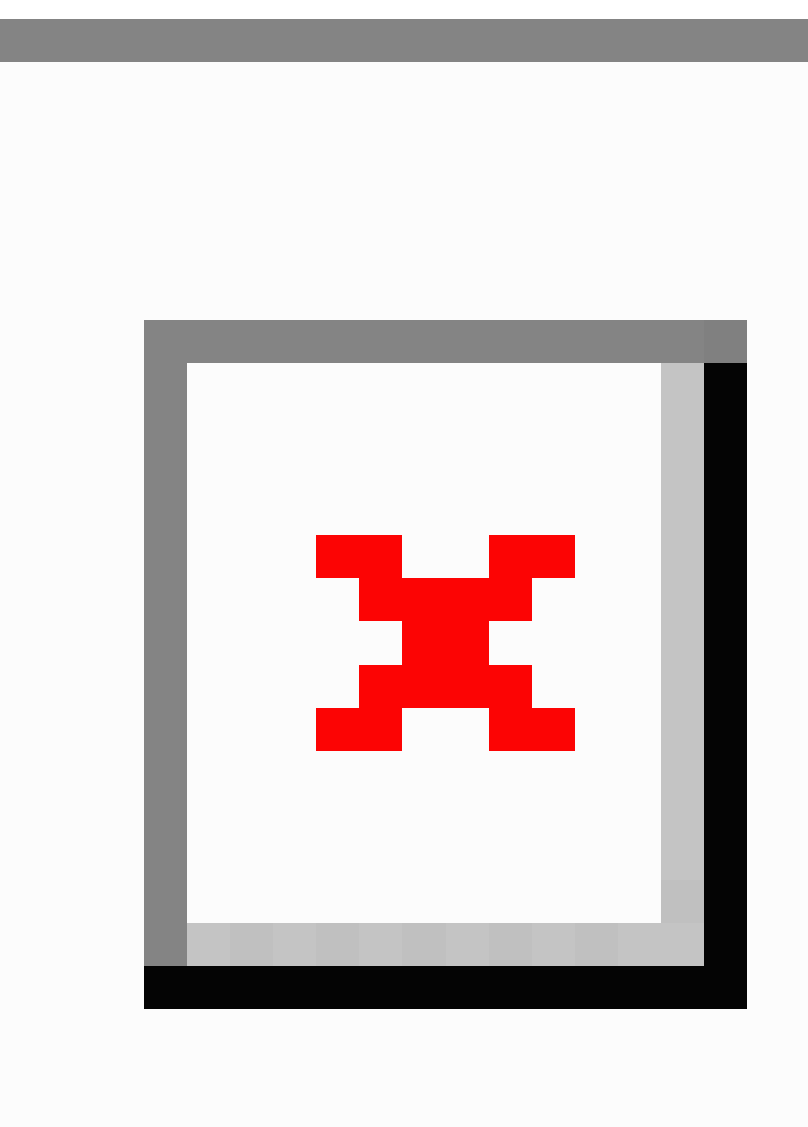
Figure 3. Networks for the Stay Healthy forum. Black squares are female, grey circles are male, the Healthy.me GP and/or counselor is represented in the red triangle.